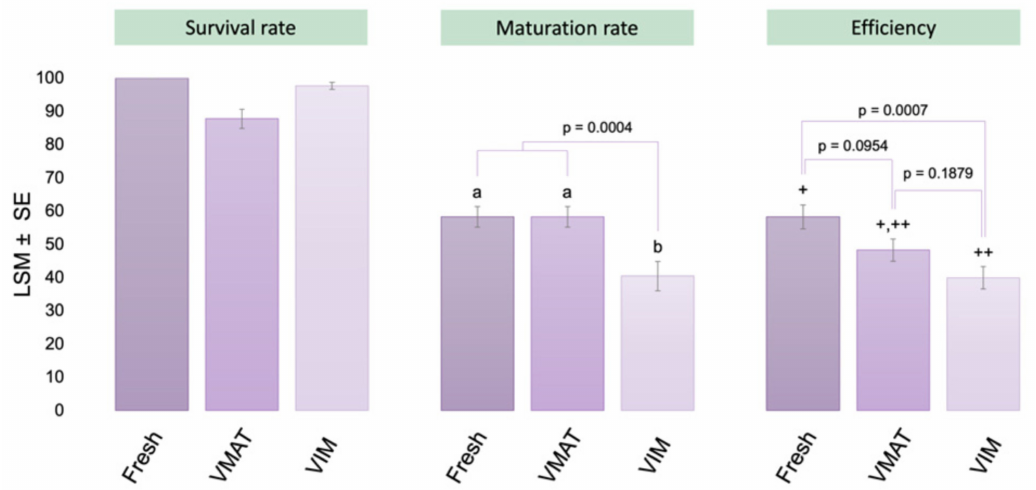
Figure 2. The survival rate is defined as the number of oocytes with an intact oolemma after warming/number of vitrified oocytes. The maturation rate is defined as the number of oocytes with an extruded polar body/number of oocytes exposed to in vitro maturation. The efficiency was calculated as the number of oocytes stored for transcriptomics/initial number of oocytes. Groups with different superscripts (a,b and +,++) differ significantly ( p < 0.05). The maturation rate in fresh and VMAT is equal since oocytes for those groups were designated after in vitro maturation, and both underwent in vitro maturation together. Group 1: fresh non-vitrified oocytes as a control (FR; n = 190); group 2: oocytes vitrified after in vitro maturation (VMAT; n = 232); group 3: oocytes vitrified before in vitro maturation (VIM; n = 210). Results are presented as n (least square means ± standard error). n = the initial number of oocytes by